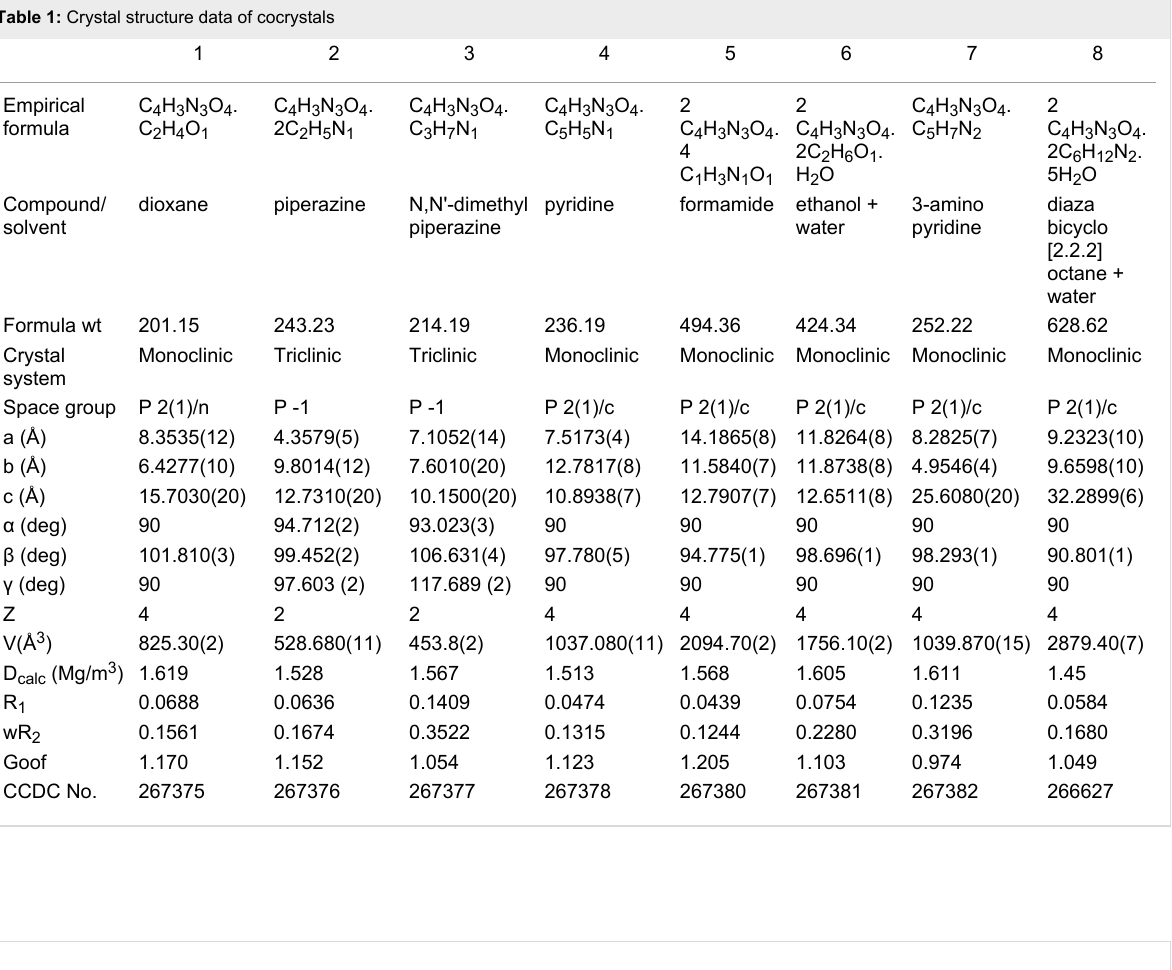
Table 1: Crystal structure data of cocrystals